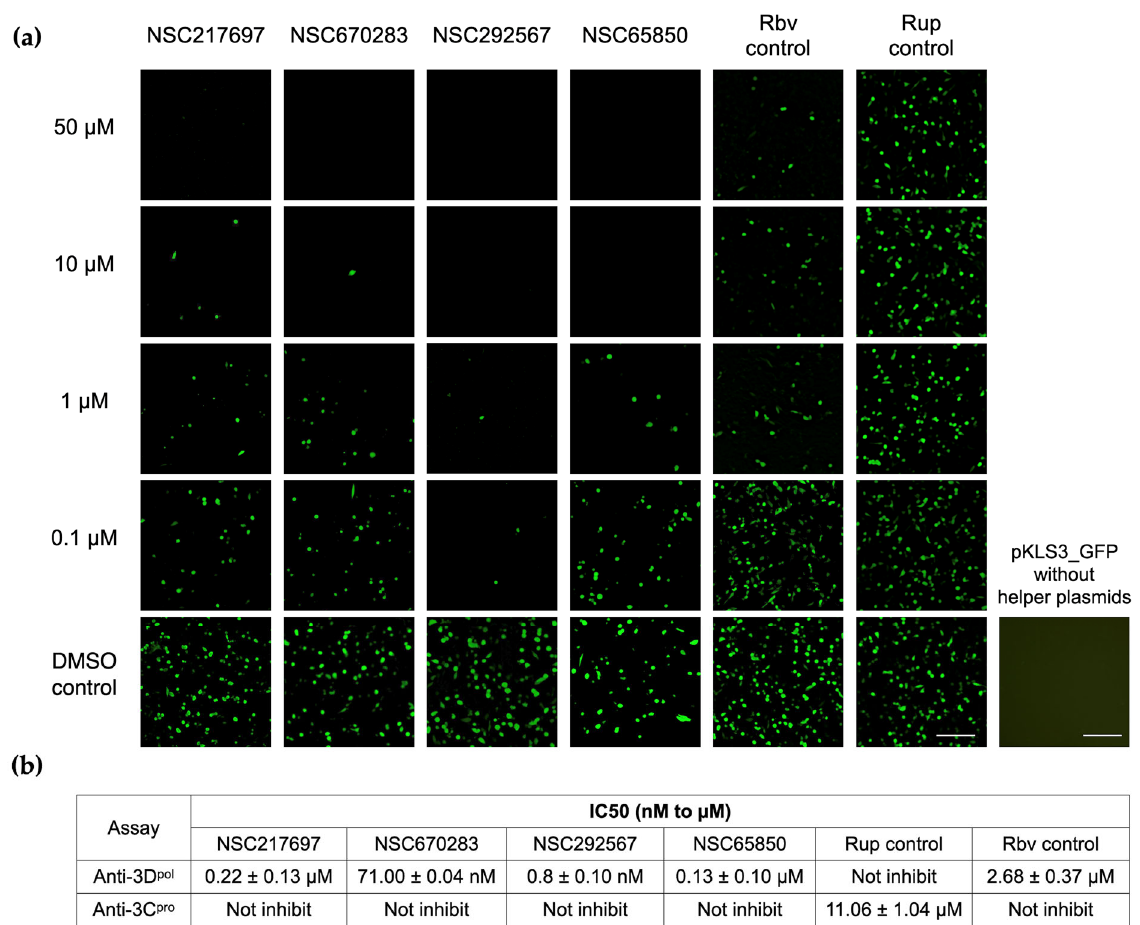
Figure 3. Cell-based 3D pol inhibition assay based on FMDV minigenome expressing green fluorescent protein. 293T cells were transfected with pKLS3_GFP and two helper plasmids, and then treated with the selected compounds in a dose-dependent manner. Ribavirin (Rbv) and rupintrivir (Rup) were used as 3D pol positive and negative drug controls, and 0.1% DMSO served as a vehicle control. No fluorescent signal was observed in the transfection well containing pKLS3_GFP in the absence of the two helper plasmids (plasmid control). The bars are 100 µM ( a ). The table shows 50% inhibitory concentration (IC50) values of the four compounds, ribavirin (Rbv), and rupintrivir (Rup) ( b ). Please note that ribavirin is the RdRp inhibitor and rupintrivir is a 3C pro inhibitor.